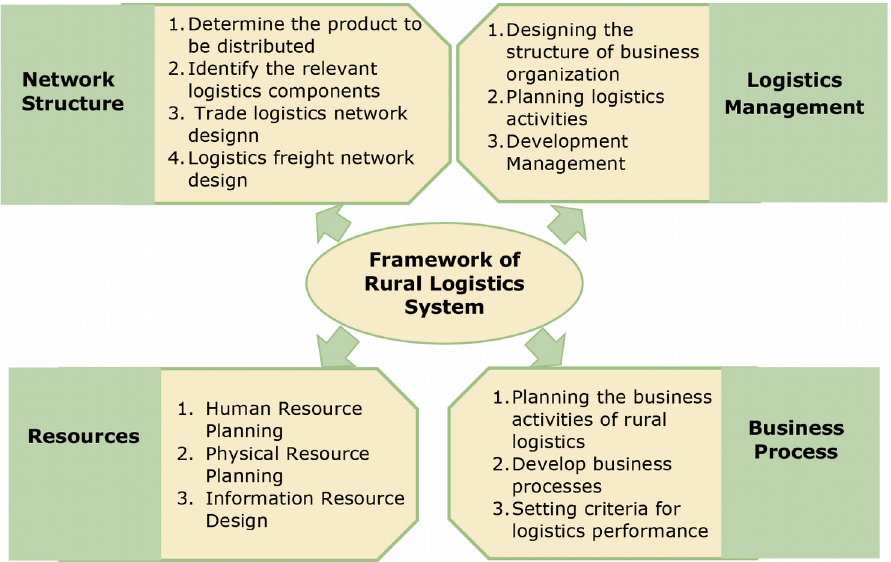
Figure 1. The conceptual framework of the rural logistics system